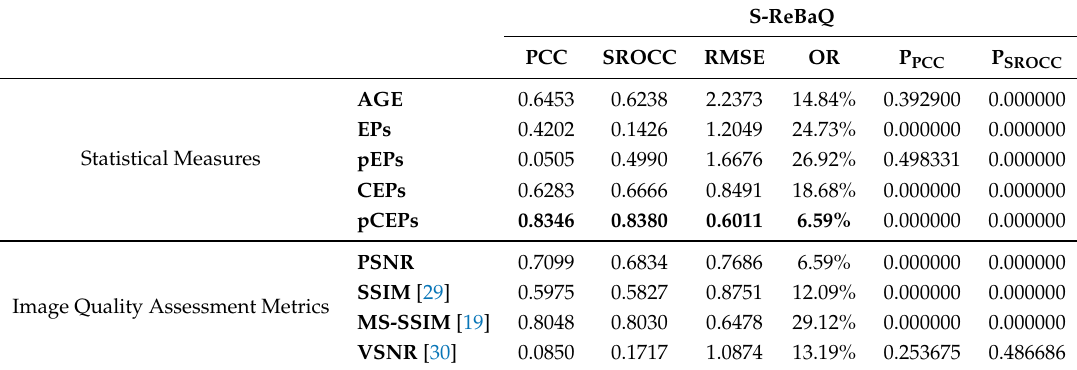
Table 2. Comparison of RBQI vs. Statistical measures and IQA techniques on the S-ReBaQ